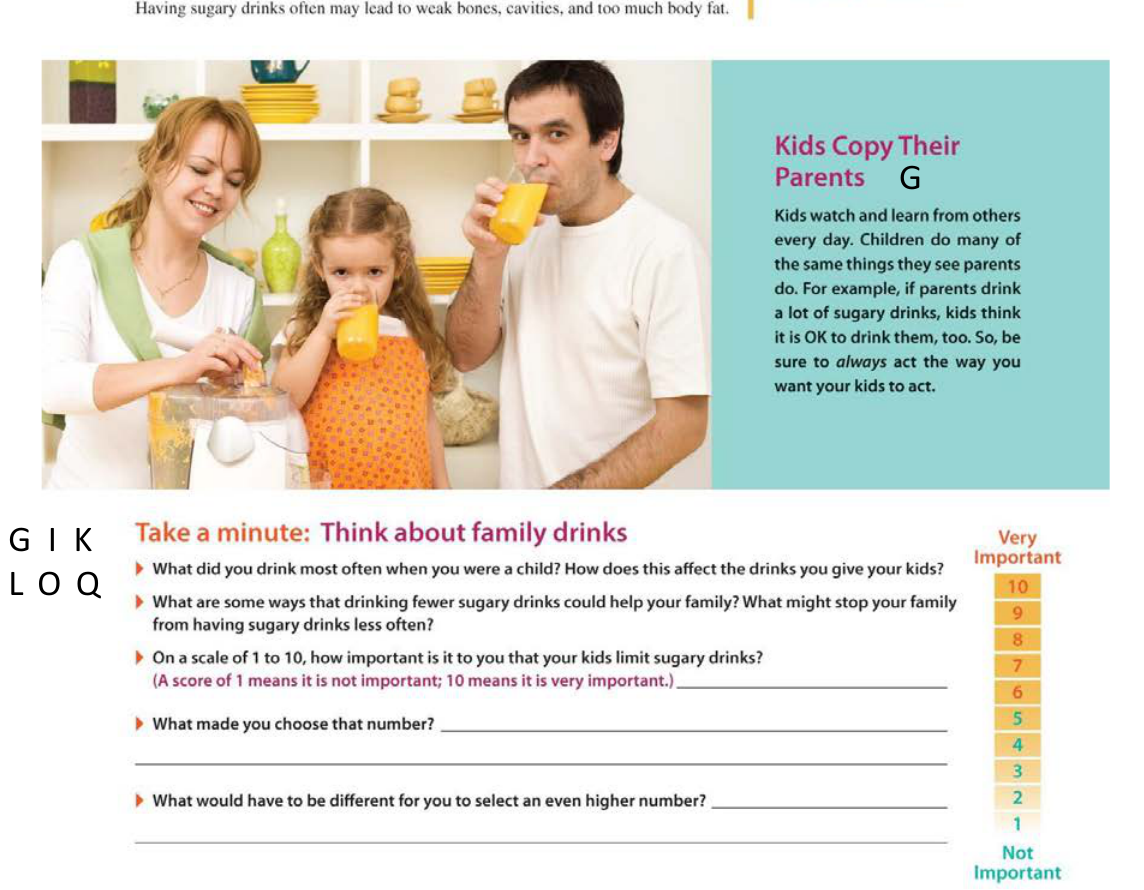
Figure 2. Cont Figure 2. Cont.